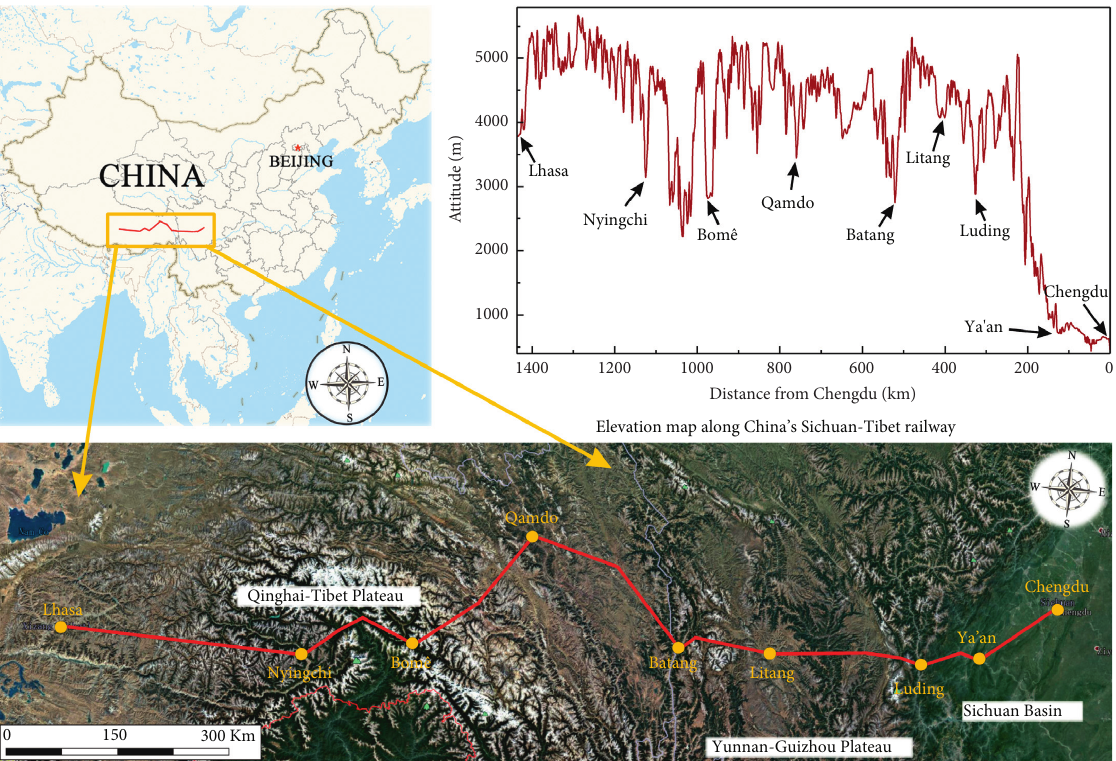
Figure 1: A route map of the Sichuan-Tibet